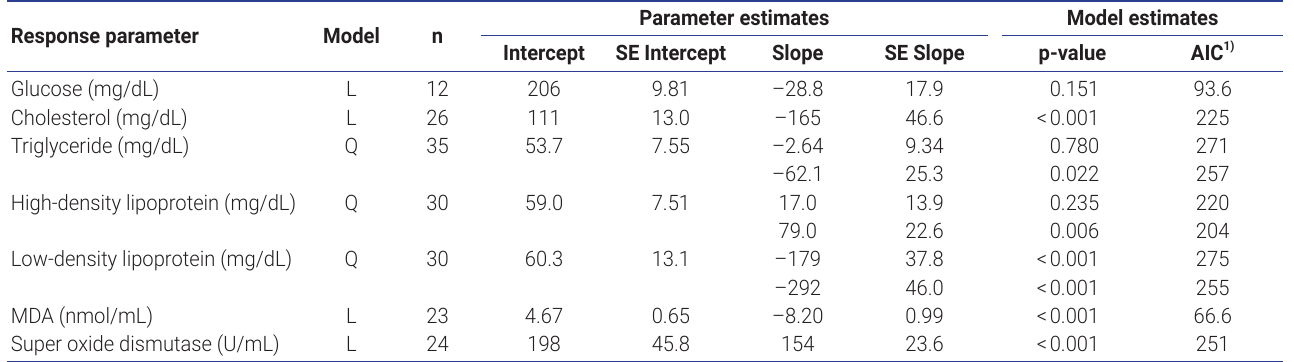
Table 4. Regression equations on the influence of flavonoid-rich herbs (in % of diet as fed) on blood constituents of broilers